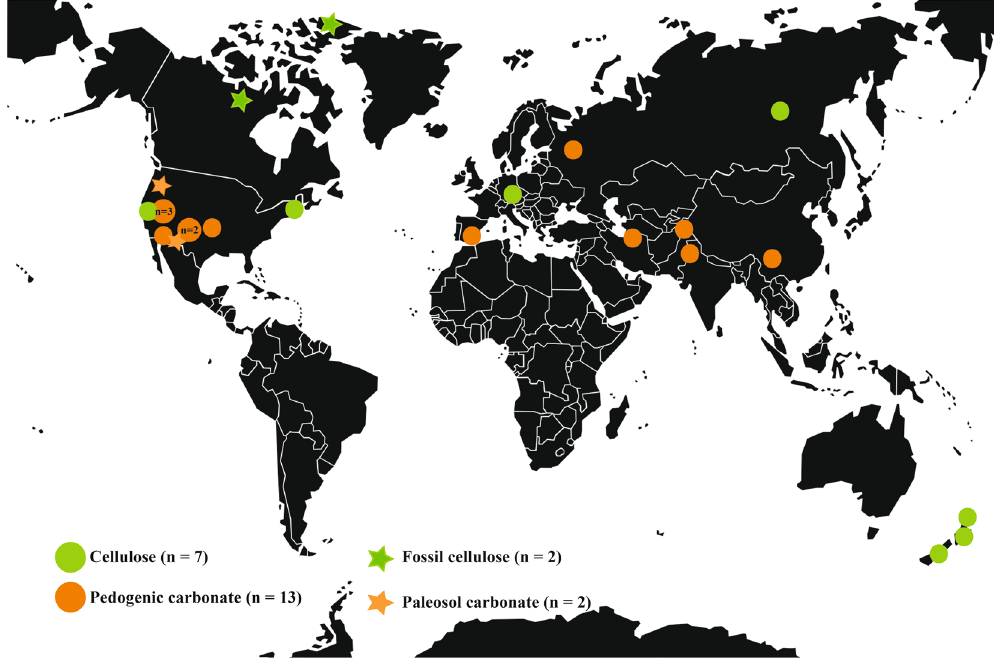
Figure 3. Approximate locations where modern cellulose (green circles, n = 8) and pedogenic carbonate (orange circles, n = 13) stable isotope data were collected (see Table S5). The locations of fossil cellulose (green stars, n = 2) and pedogenic carbonate (orange stars, n = 2) used for paleo-VPD estimates are also noted.